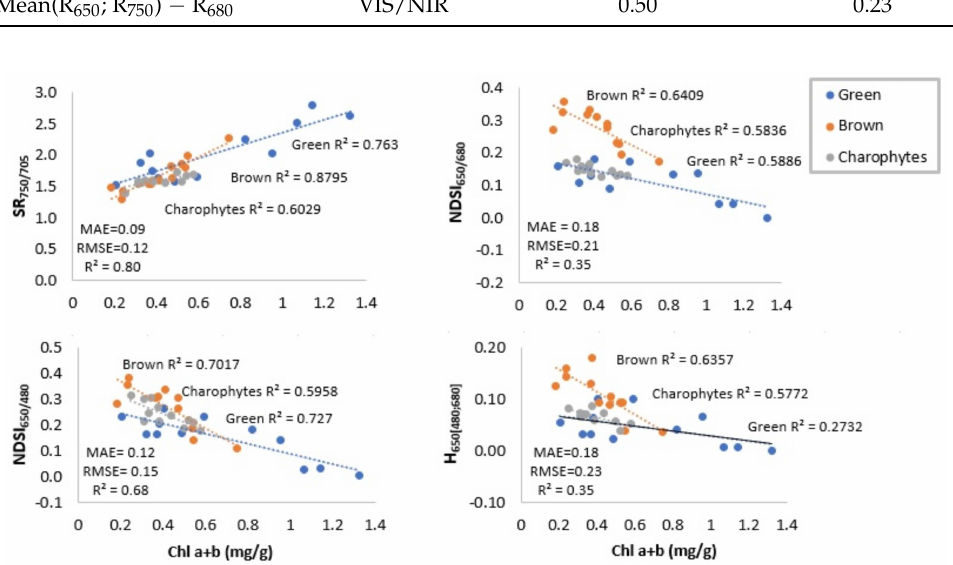
Figure 5. Relationships between chlorophylls concentration (mg/g wet wt Chl a+b) and selected spectral indices. Indices are calculated from the WW dataset. Root mean square error (RMSE) and mean absolute errors (MAE) are given for combined